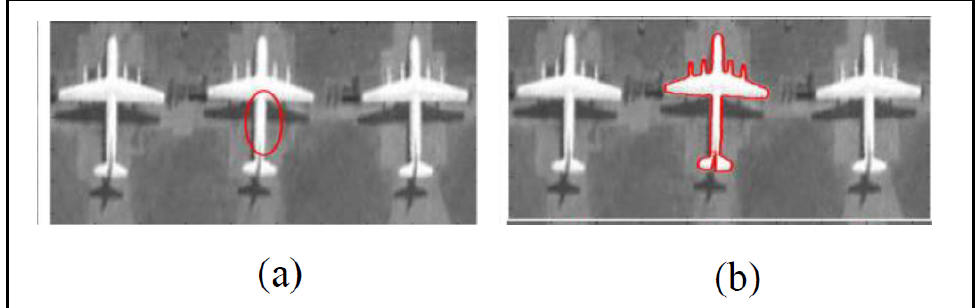
Figure 5. An example of global segmentation property of the C-V model. ( a ) shows the initial contour and ( b ) shows the segmentation result of the C-V method, which cannot extract all boundaries in the